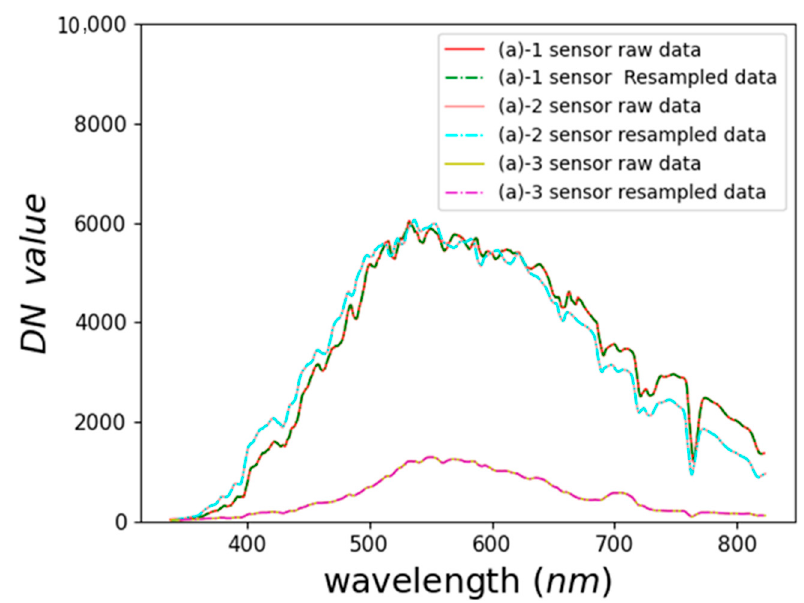
Figure 2. Comparison of raw and resampled data.